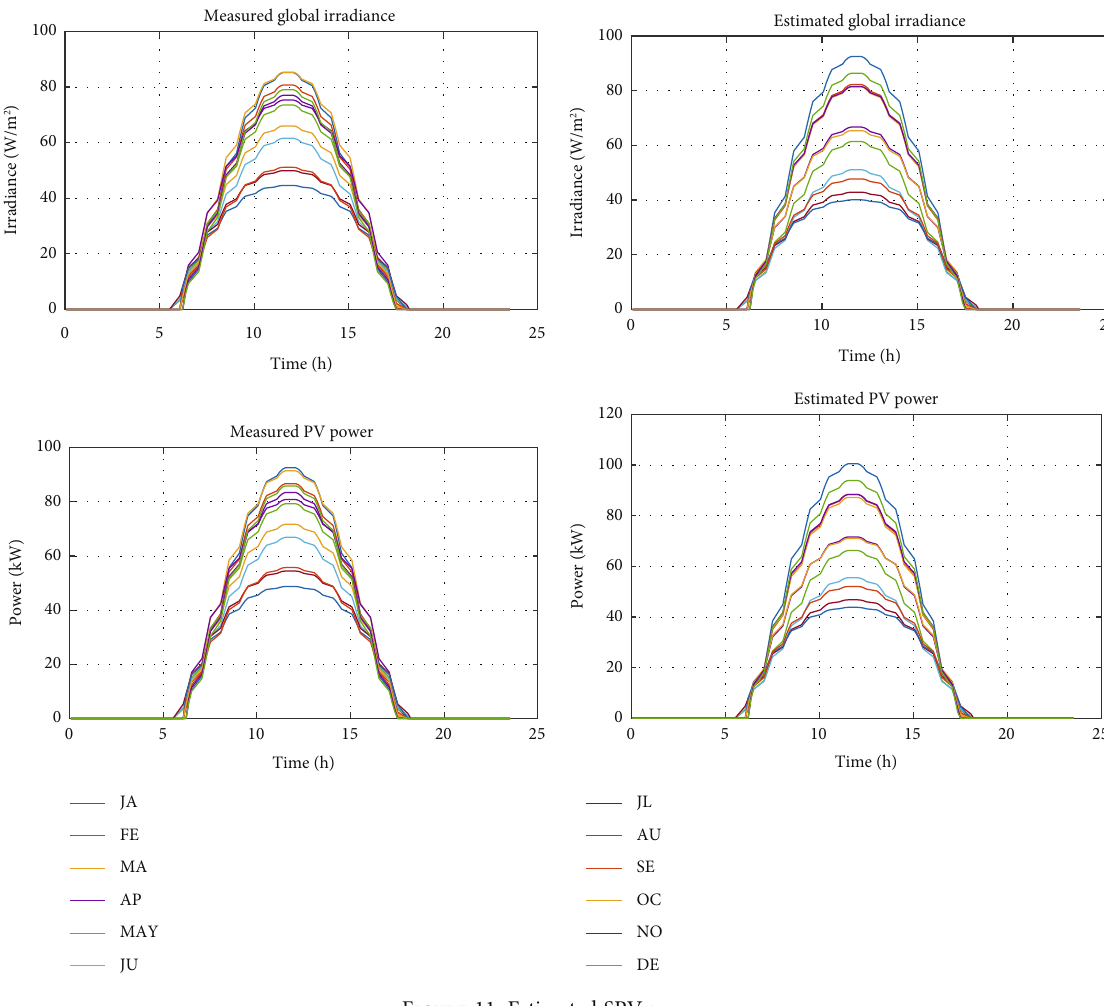
Figure 11: Estimated SPV